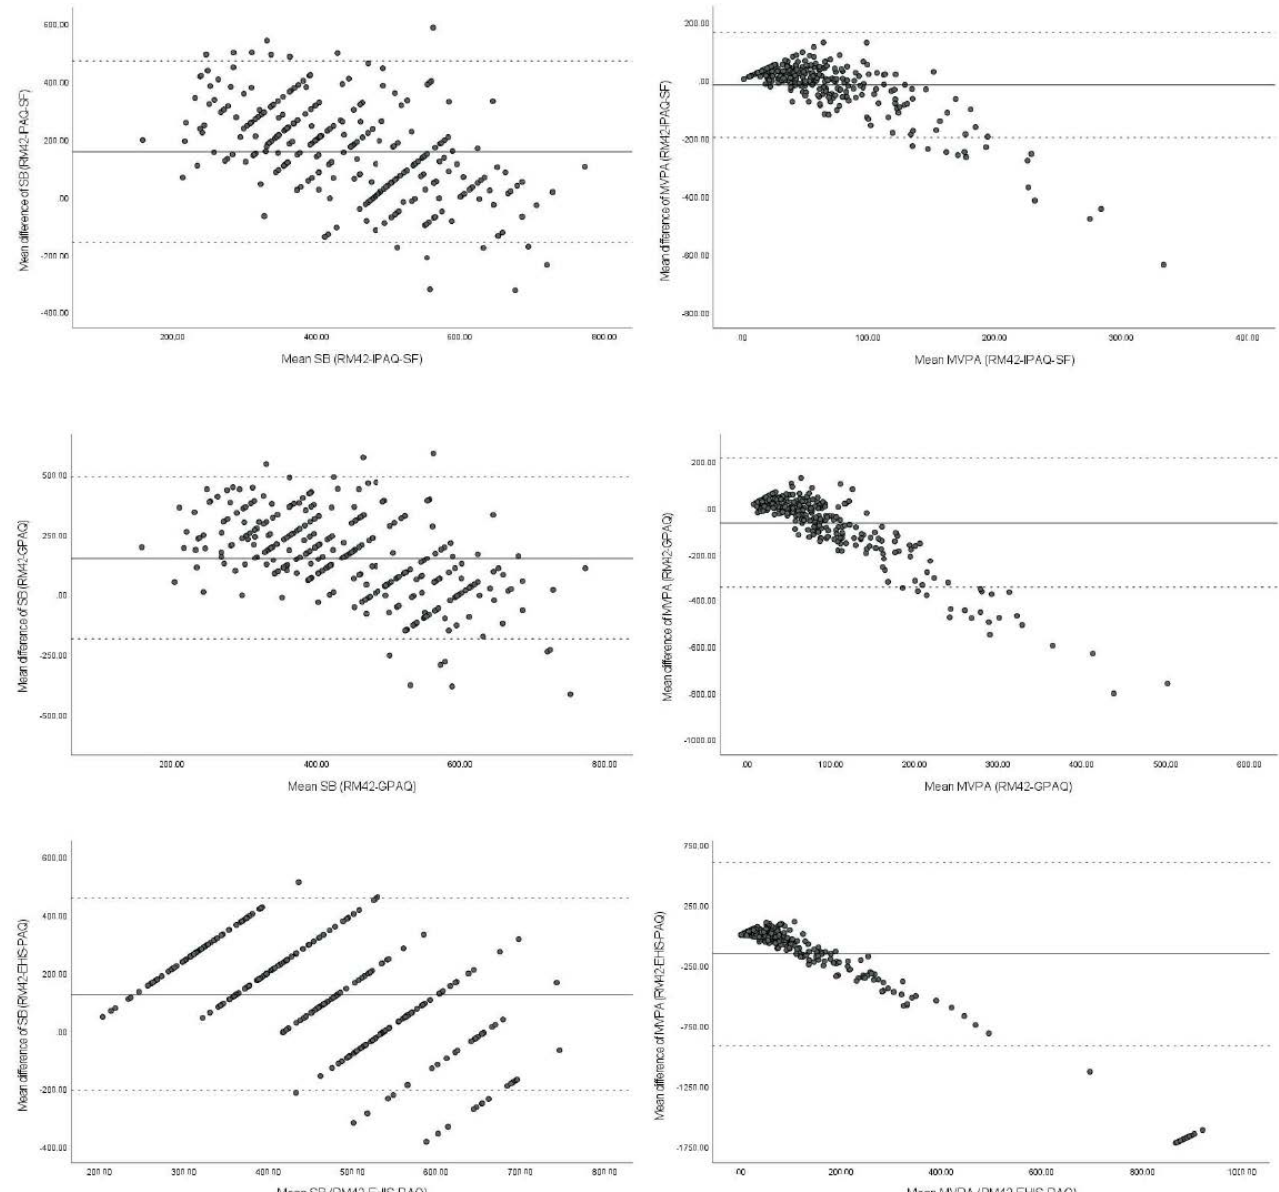
Figure 1. Bland-Altman plots for the PAQs and UKK RM42 accelerometer according to sedentary behavior and MVPA (min/day) with 95% limit of